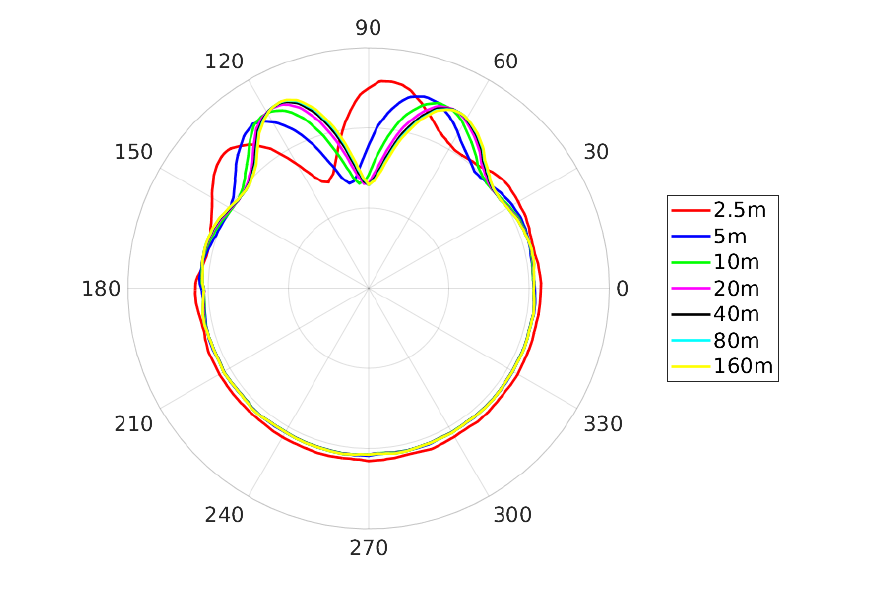
Figure 13. Directivity pattern at 1st BPF for different observers distances.